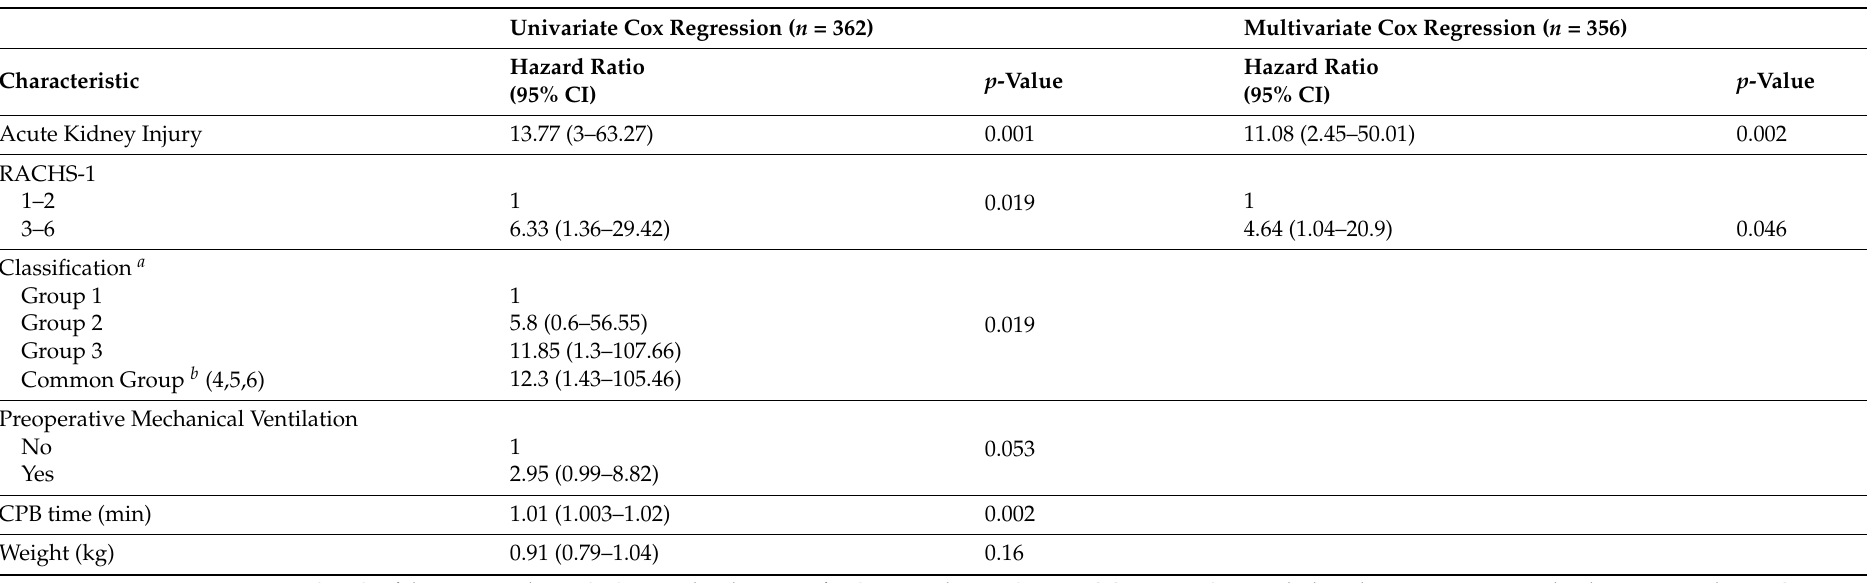
Table 6. Univariate and multivariate Cox regression according to postoperative Acute Kidney Injury development.